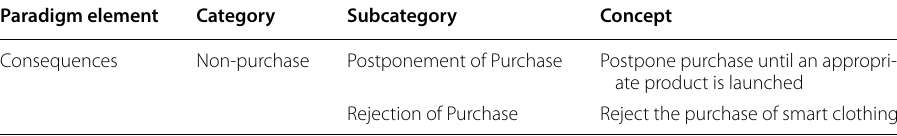
Table 5 Categories, subcategories, and concepts of consequences Paradigm